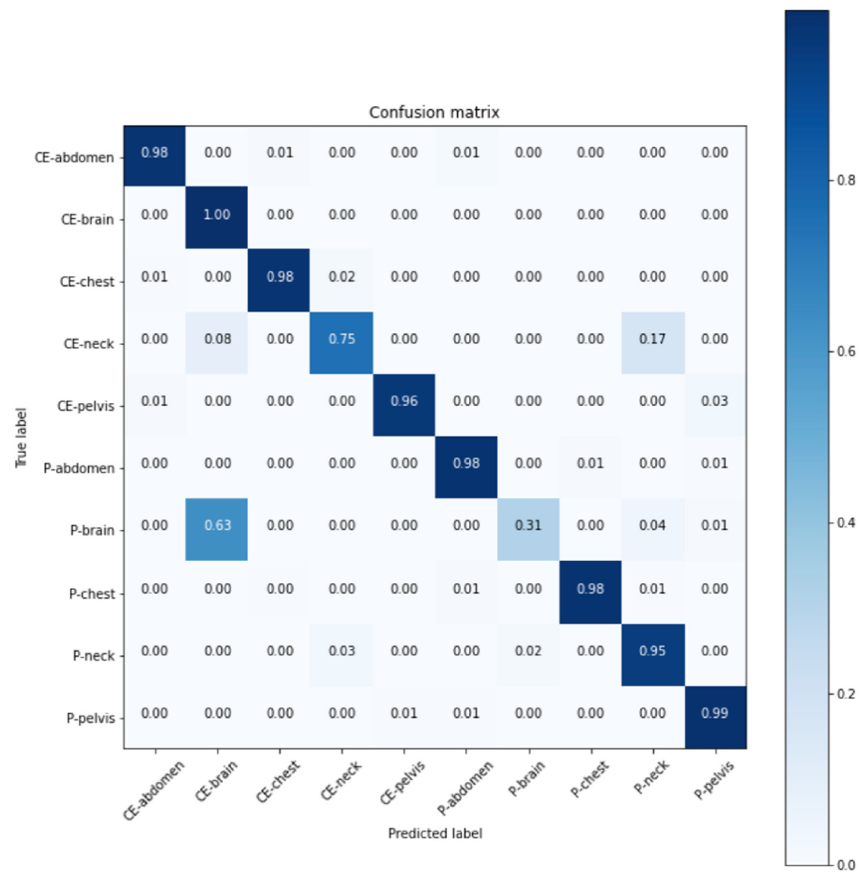
Figure 10. Confusion matrix of ResNet (CE: contrast-enhanced, P: plain).